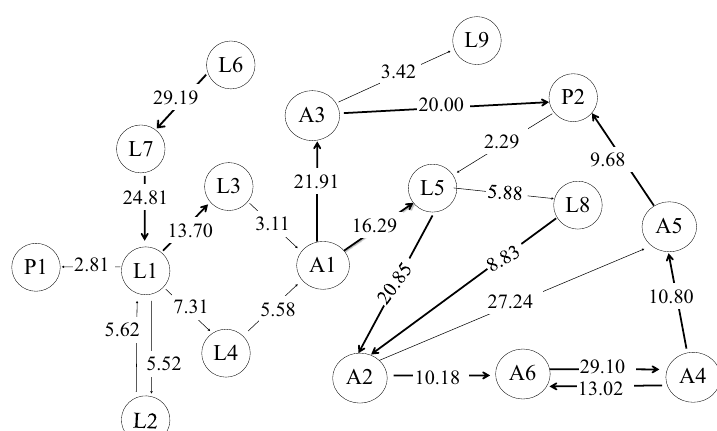
Fig. 8 Behavioral patterns of the GAIER group